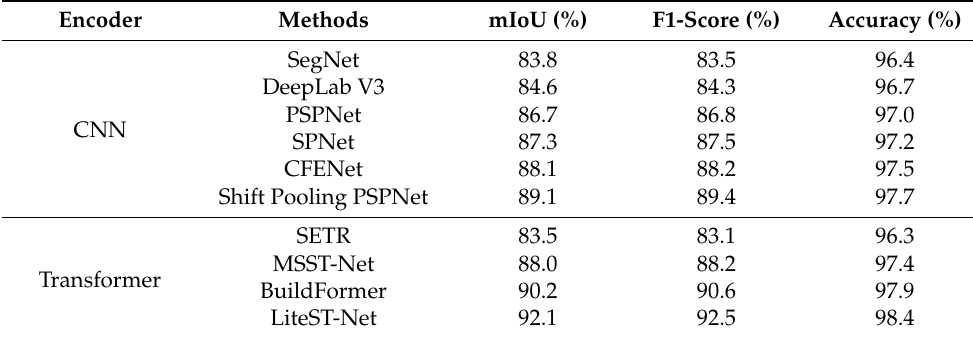
Table 1. Results of classic networks on the WHU building test